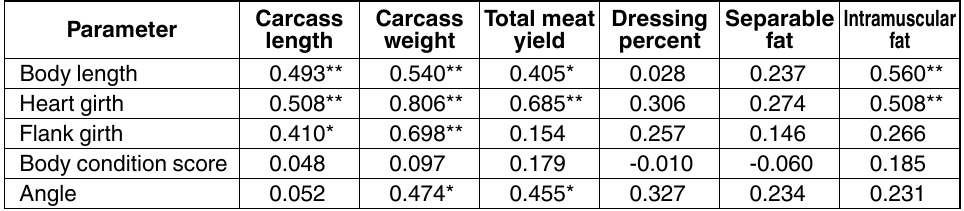
table 1. Coefficients of correlation between different live animal and carcass parameters of pigs from weight group I